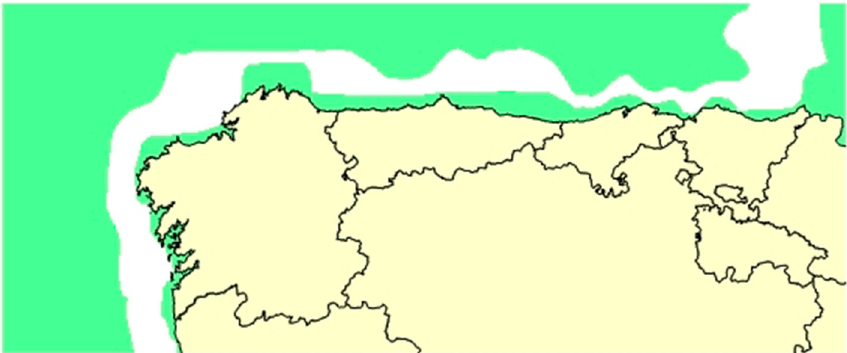
Figure 7. Bathymetry restriction for the semisubmersible platform.